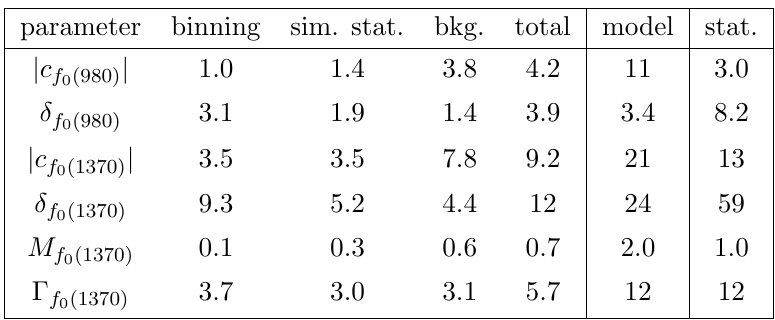
Table 5 . Systematic uncertainties (%) on the results of the isobar model (cid:12)t. For comparison, the statistical uncertainties are listed in the last column.